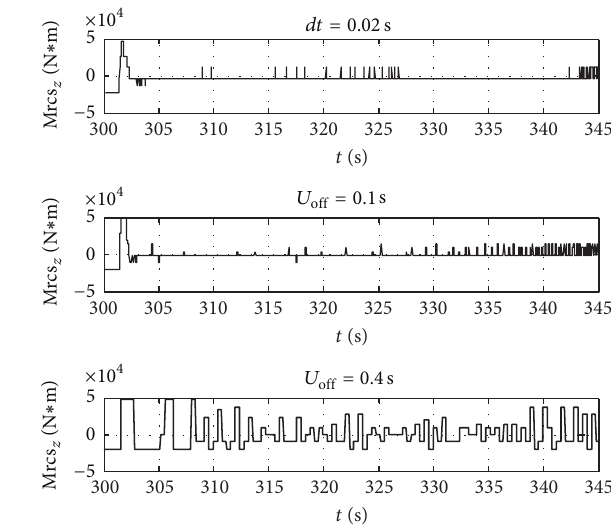
Figure 37: Simulation result of RCS pitch moment.